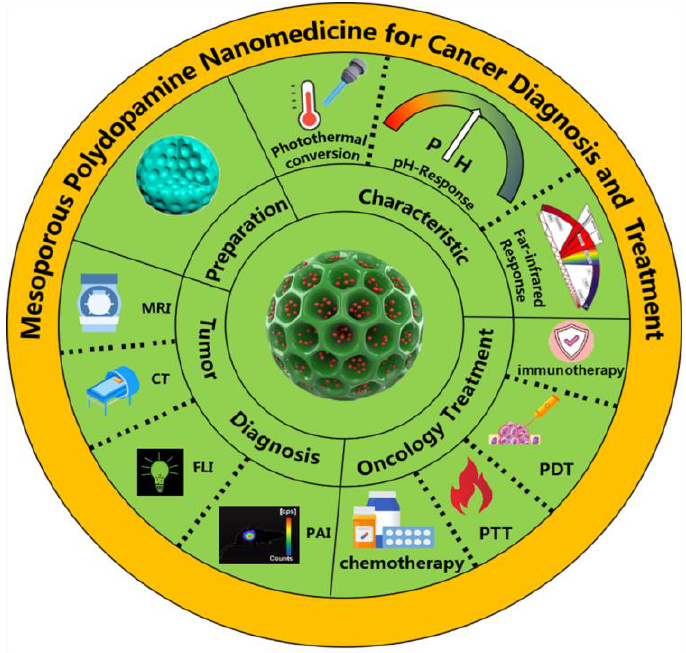
Figure 1. Schematic illustration of preparation, characterization, and tumor application of